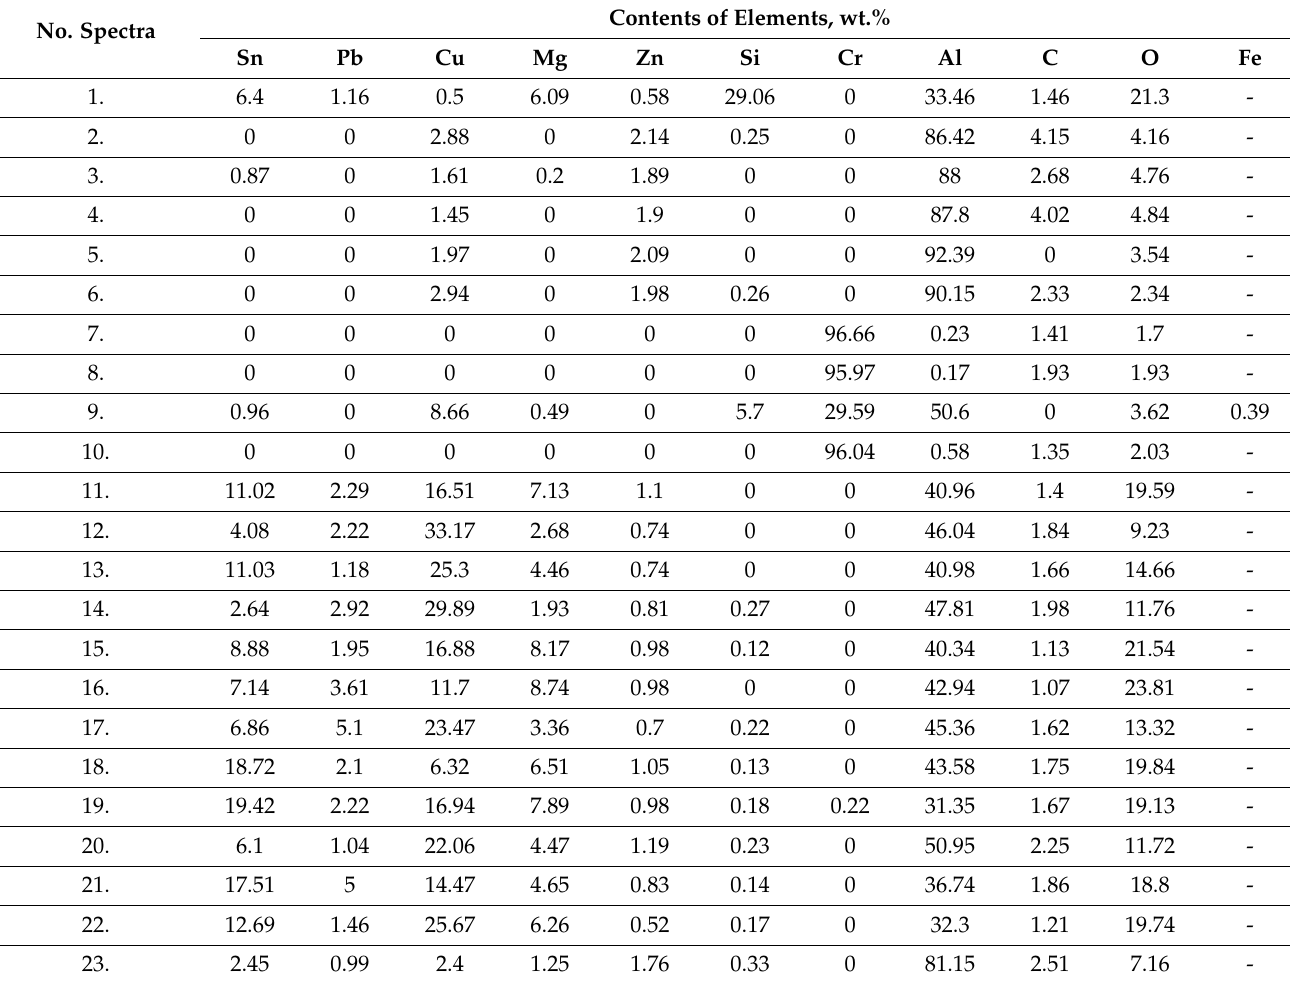
Table 6. EDS chemical identification of elements and their concentration in Al–Cr